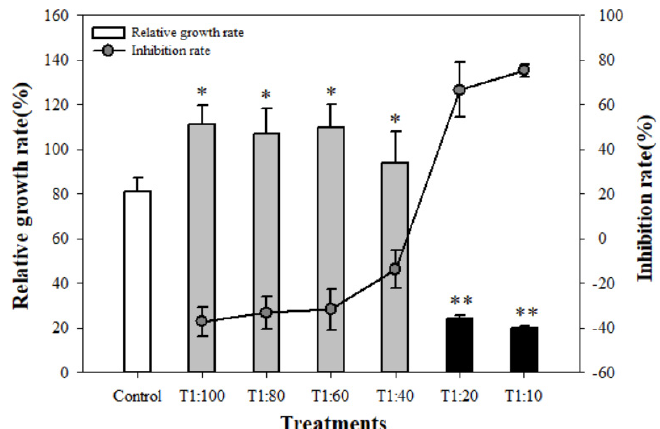
Figure 2. Relative growth rates and inhibition rates of Ulva prolifera under the exposure of different amounts of cell ‐ free filtrate of Bacillus cereus BE23. T 1:100 , and T 1:80 ~T 1:10 indicate the treatments of volume ratio of cell ‐ free filtrate of Bacillus cereus BE23 to f/2 medium. Values are means ± SD (n = 3). * indicates a significant difference ( p < 0.05) and ** indicates a significant difference ( p < 0.001) compared to control.